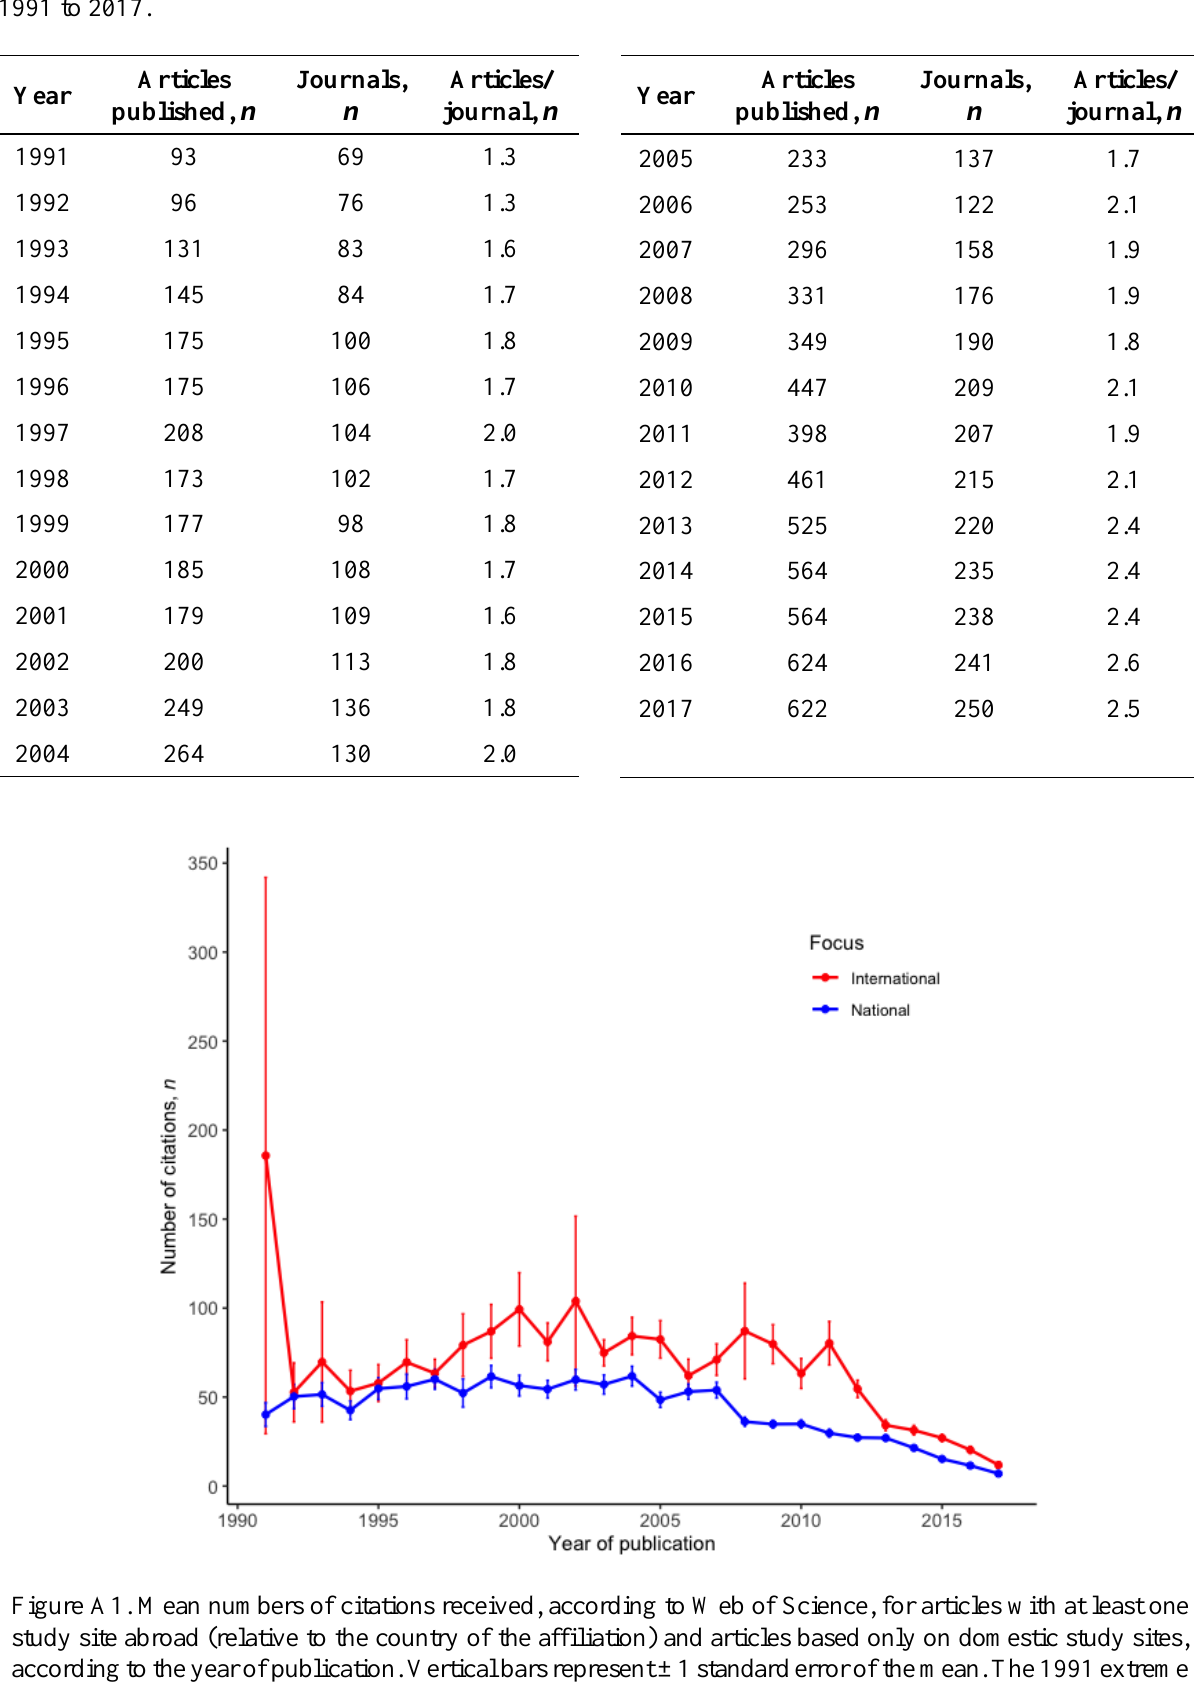
Table A2. Number of articles published, number of journals, and average number of articles per journal, from 1991 to 2017.